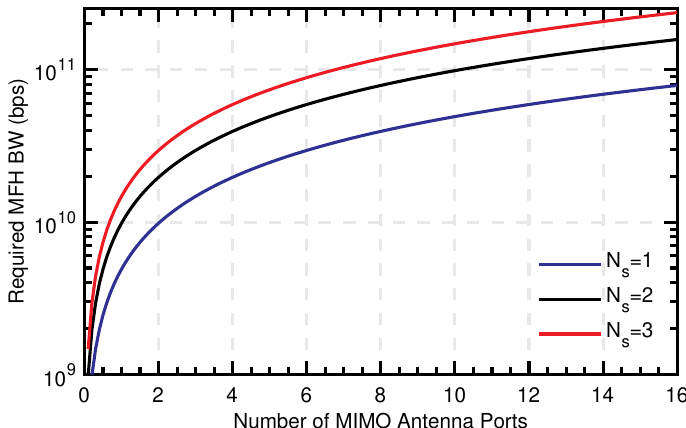
Figure 27. Required MFH capacity for different